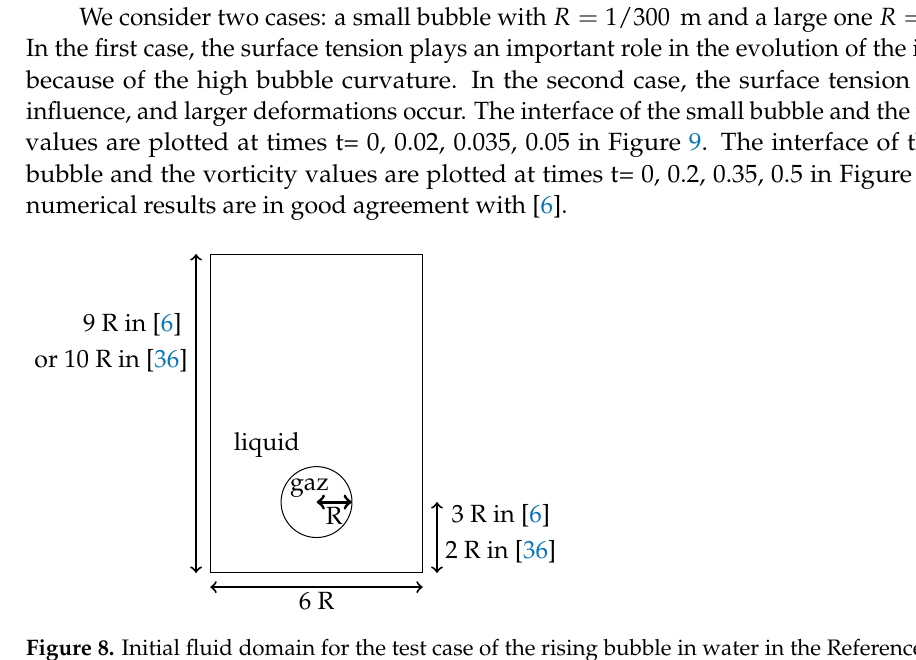
Figure 8. Initial fluid domain for the test case of the rising bubble in water in the References